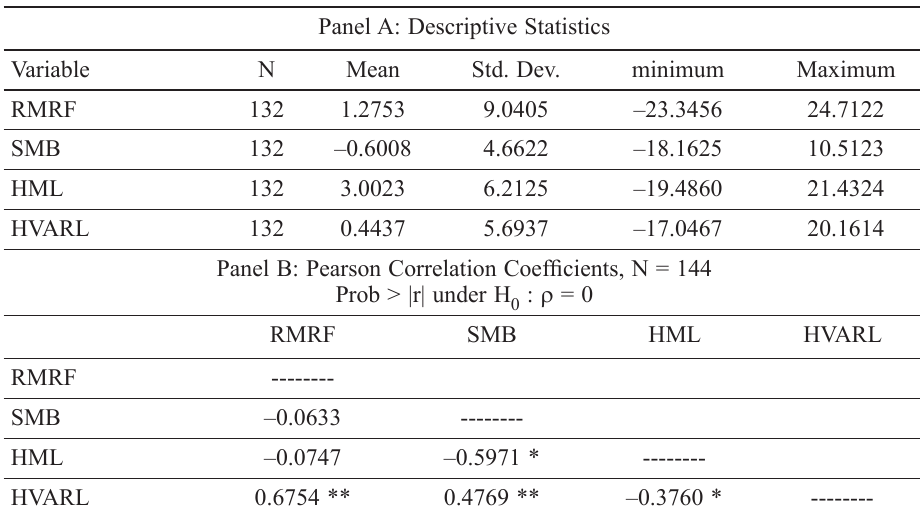
Table 2. Time series regressions – descriptive statistics